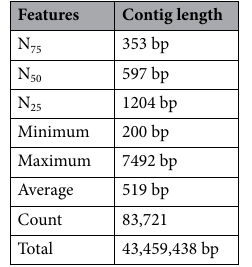
Table 3. d e Novo assembly statistics of master